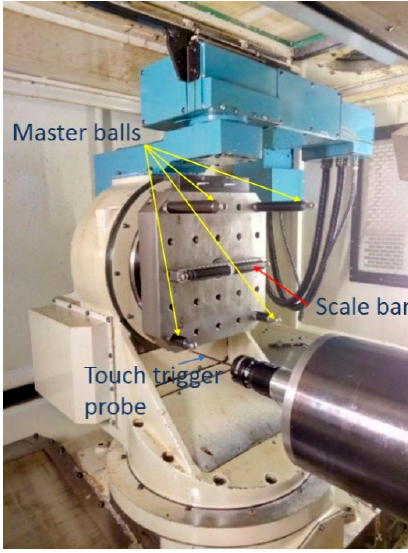
Figure 1. Scale and master ball artefact (SAMBA) measurement process on the HU40-T five-axis machine tool.